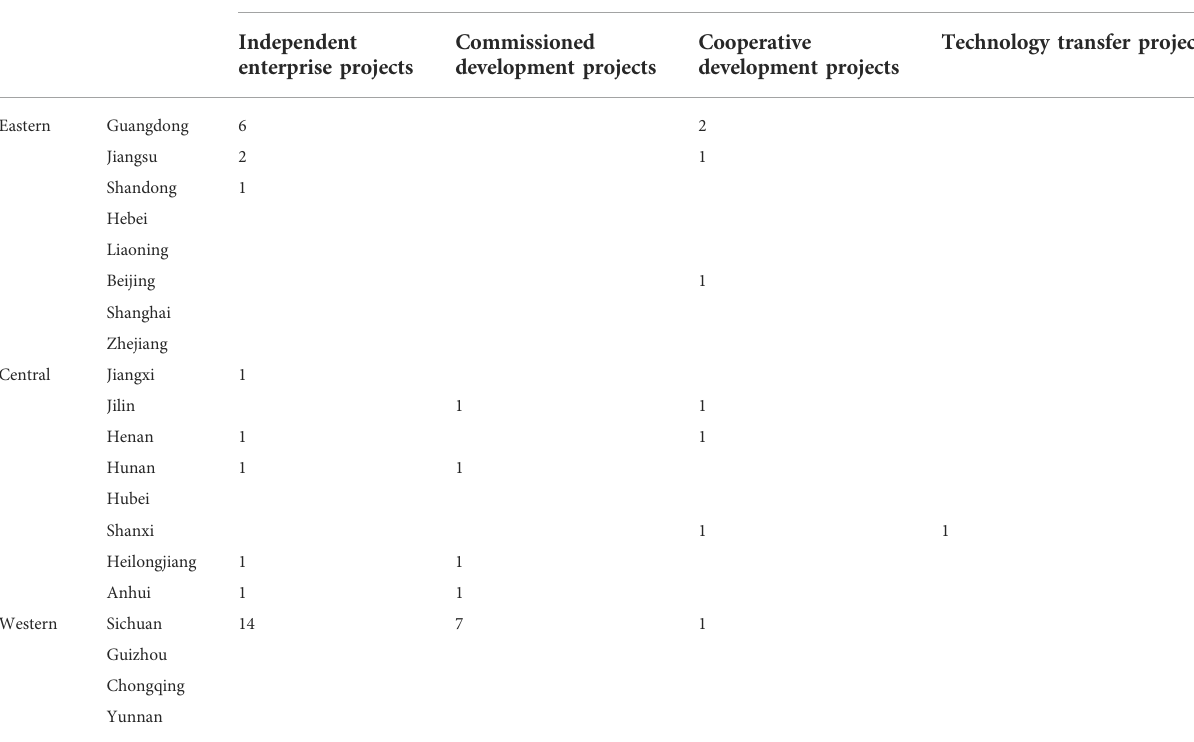
TABLE 3 Distribution of the number of projects in progress in the past 3 years.